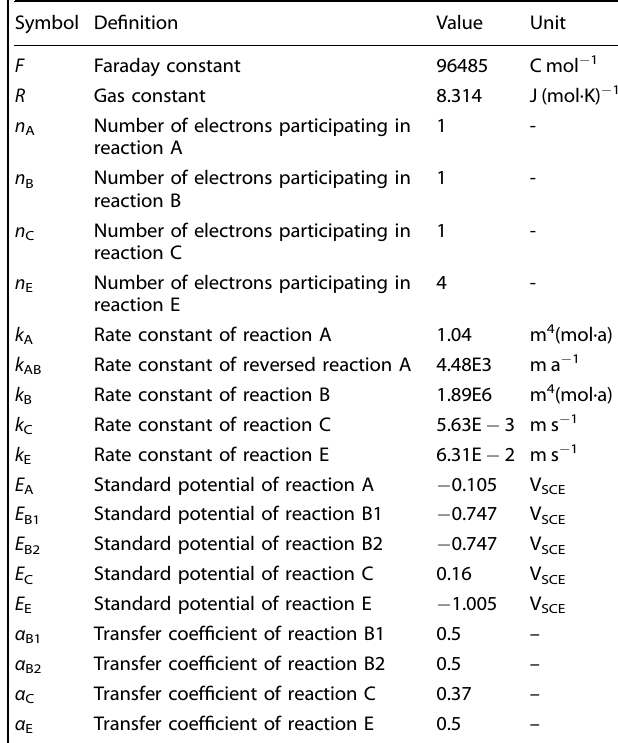
fi nition of parameters and corresponding values used in this